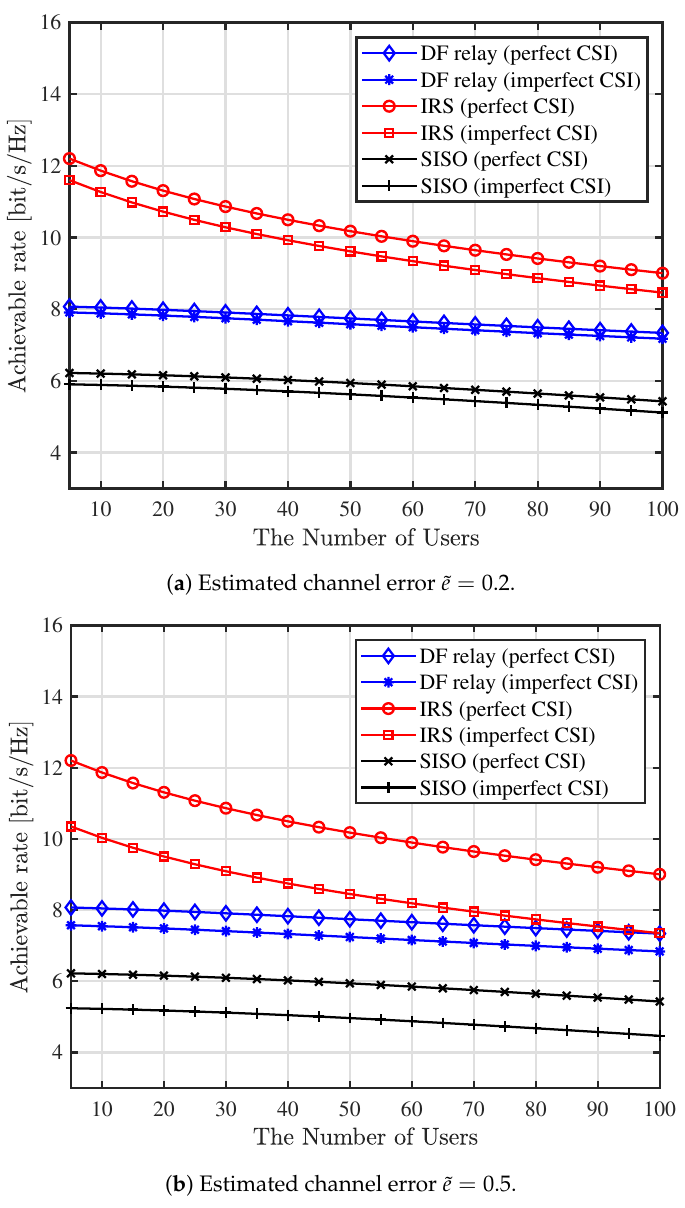
Figure 6. The achievable rate for different number of users where d 1 and d sr are set to fixed values of 100 m and 80 m, respectively, in terms of perfect and imperfect